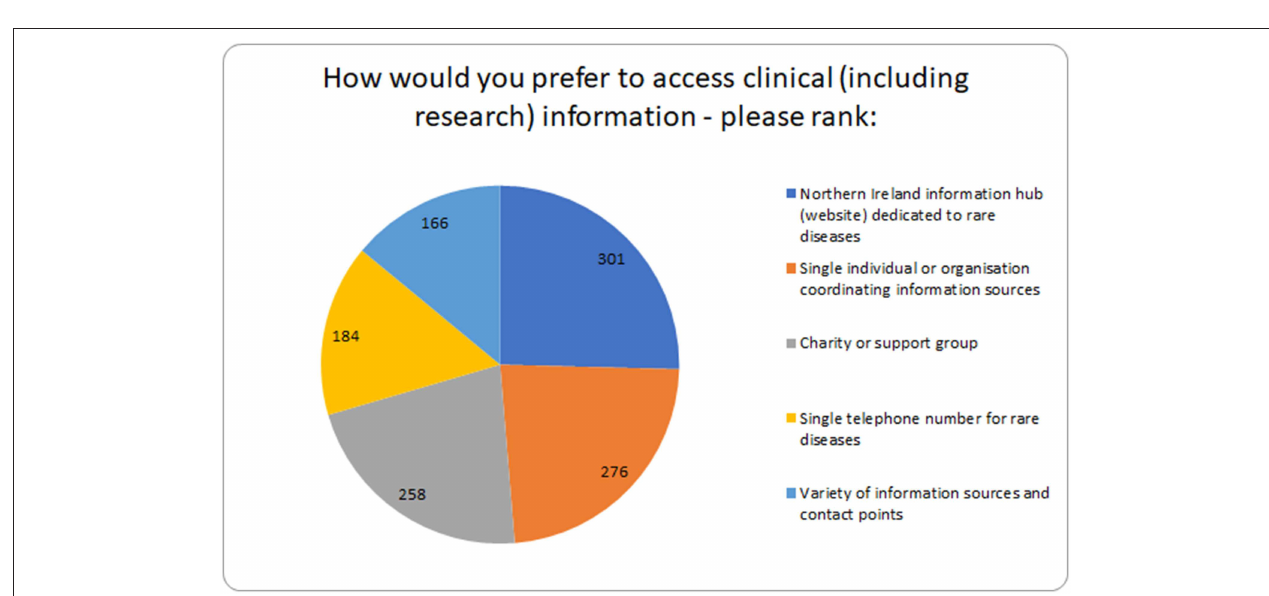
FIGURE 5 | Summary of how individuals prefer to access clinical and research